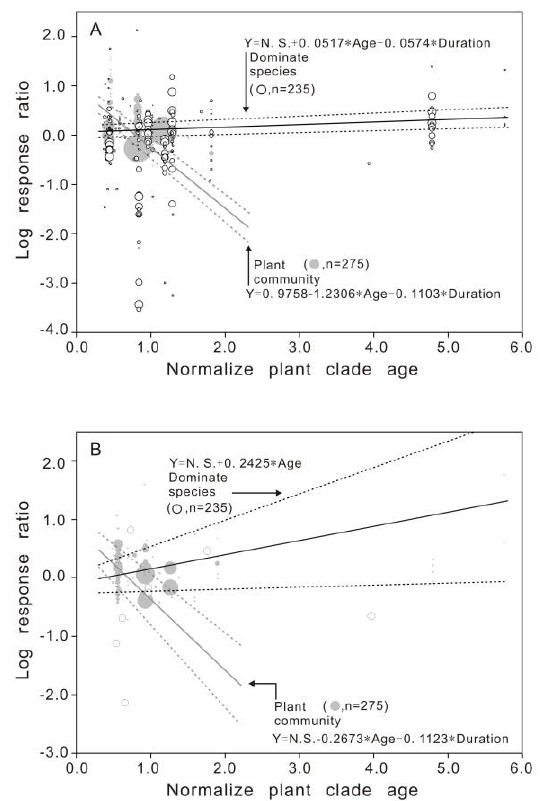
Figure 3. The effect of plant clade age (Plant CA ) and warming duration (Warm D ) on warming-induced biomass accumulation of the plant community (gray circle, Biomass CW ) and its dominant species (open circle, Biomass DS ). The size of the circle indicated the difference across Warm D . ( A ): Above-ground biomass (AGB); ( B ) Below-ground biomass (BGB). Corresponding equations showed the results of multiple mixed-effects meta-regression models, which considered Plant CA , Warm D , and plant biomass. N.S.: no significance in “Intercept” of the model ( p > 0.05); n : the number of collected